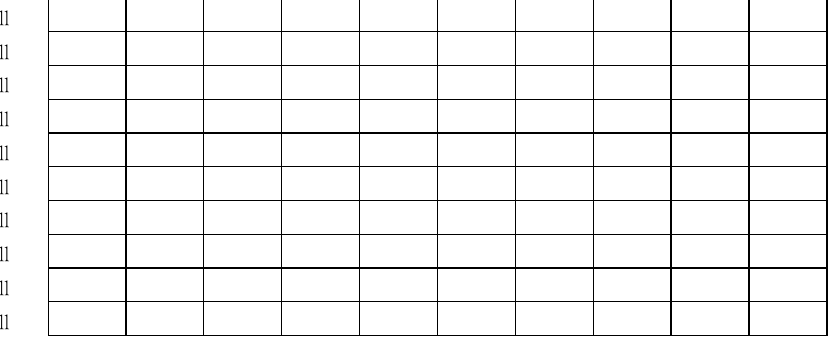
Figure 5. Generated a PF by duplicating a cell ( PacketSize × N ).